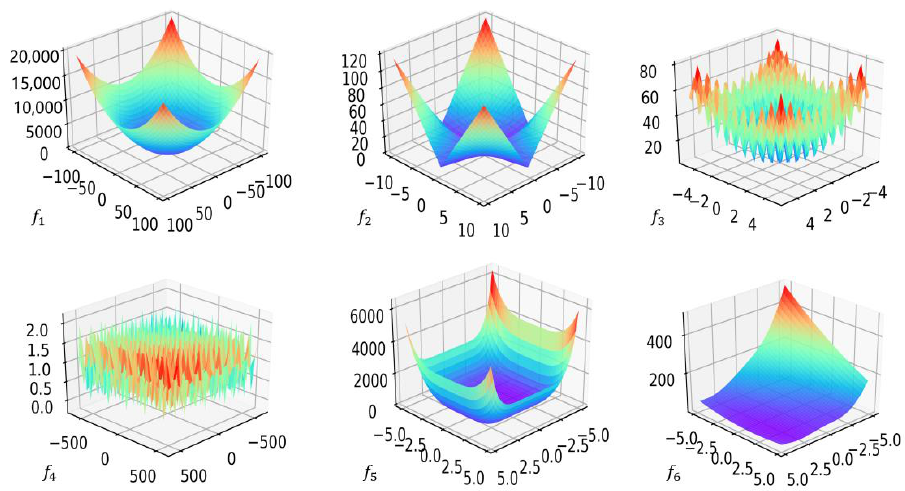
Figure 5. Three-dimensional graphs of functions. Table 2. Test functions.